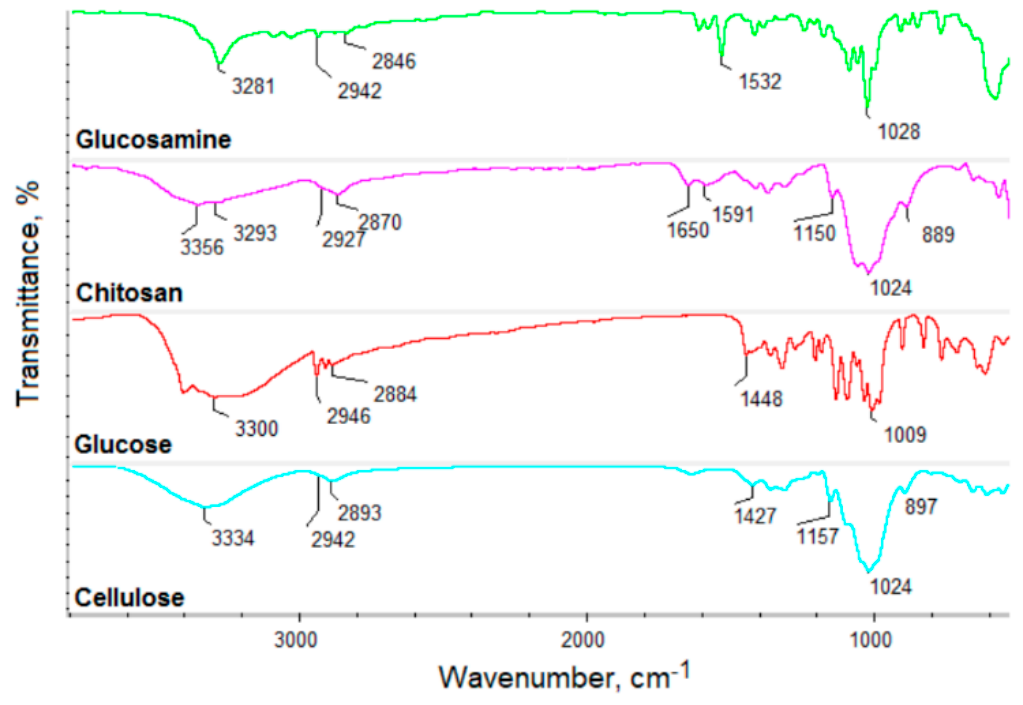
Figure 2. FT-IR spectra of the starting materials for the CQD’s preparation.